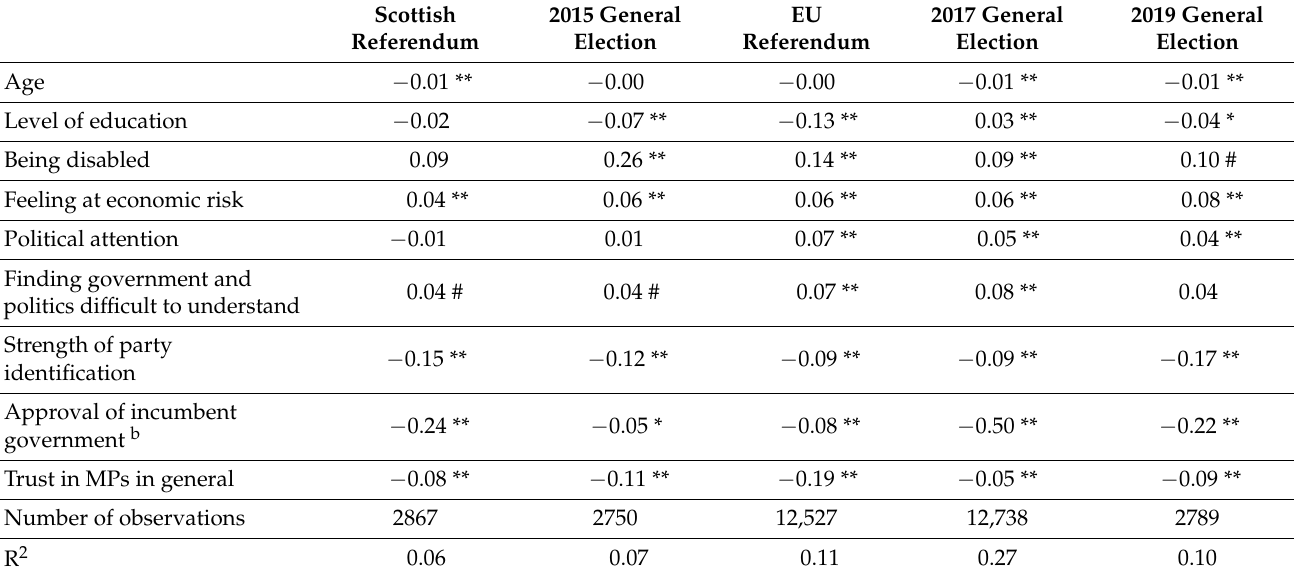
Table 3. Regressing expectations of electoral (un)fairness for different electoral events a